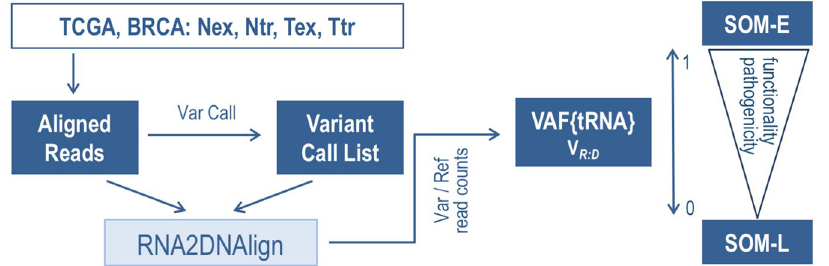
Figure 1. Major steps of the analysis of allele distribution for somatic variants in our dataset. V R:D was analyzed for correlation with different functional mutations groups in oncogenes, tumor suppressors, and the rest of the genes. SOM-E and SOM-L variants were compared with the rest of the somatic mutations for predicted pathogenicity and location in functional motifs such as transcription and splice factor binding sites, and highly preserved